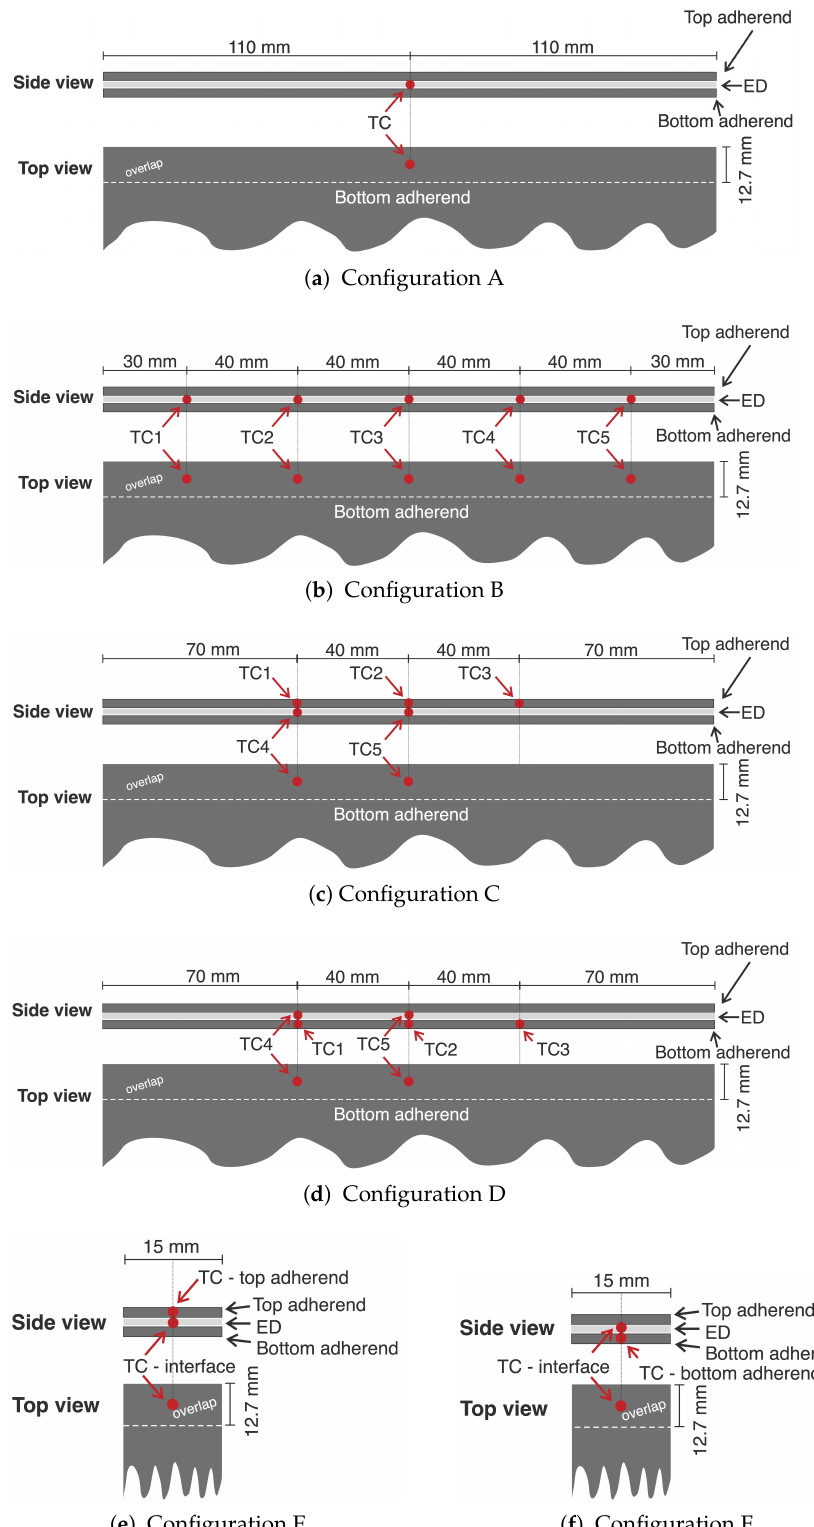
Figure 4. Schematic side and top view of the temperature measurement configurations used in this study on 220 mm wide and 15 mm wide